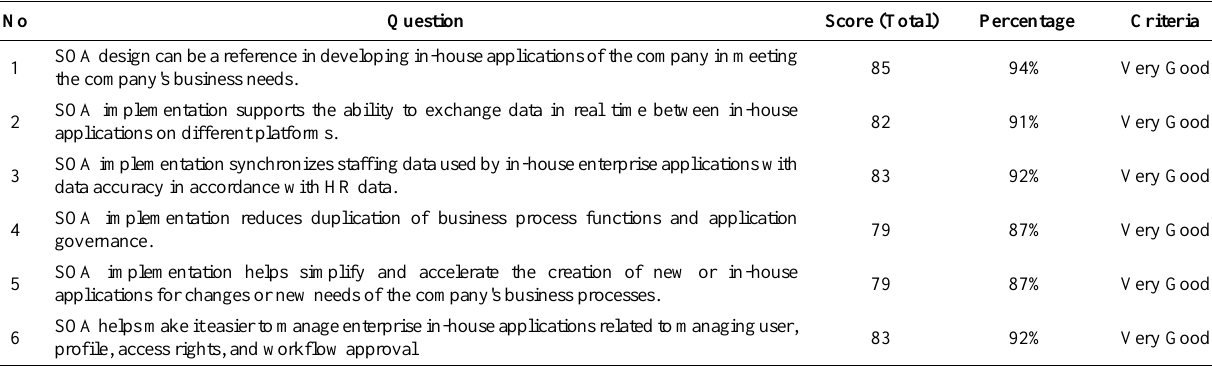
Table 4. Questionnaire Result